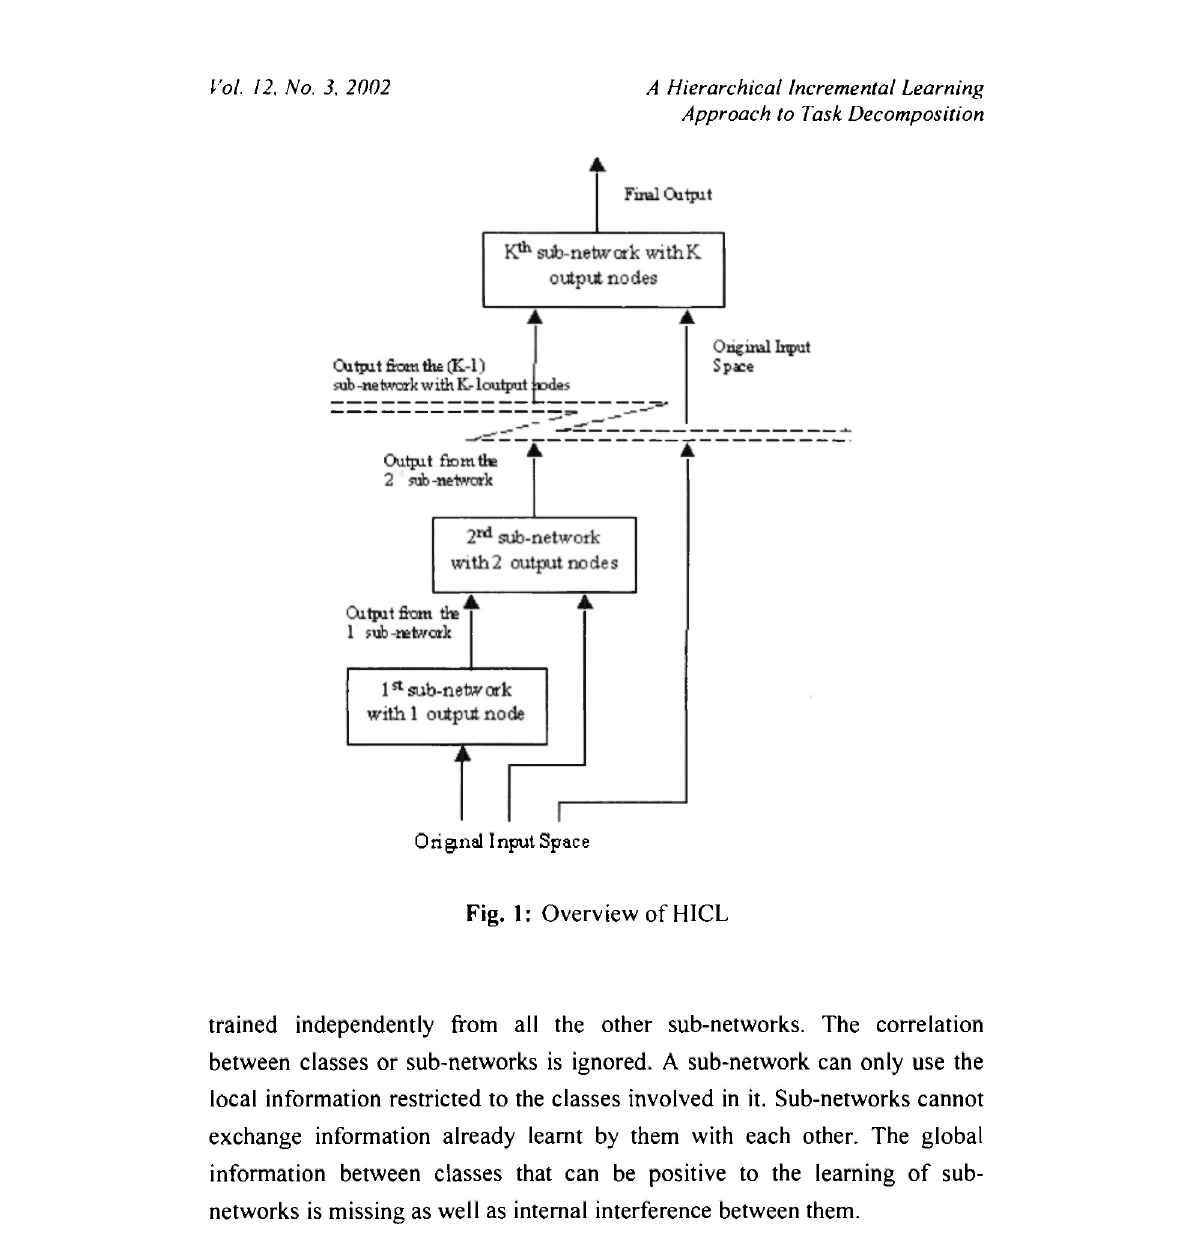
Fig. 1: Overview of